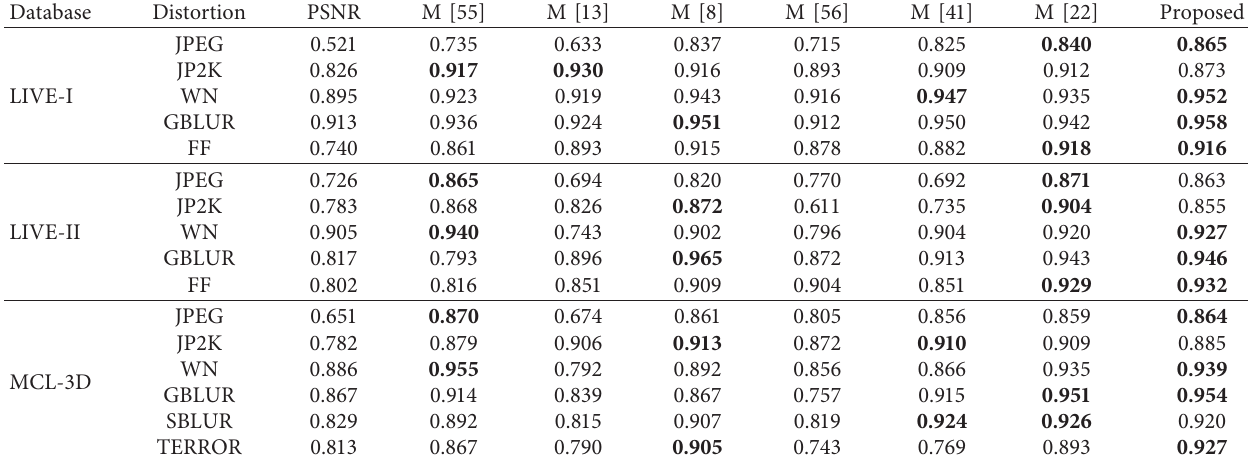
Table 2: PLCC comparison for each type of